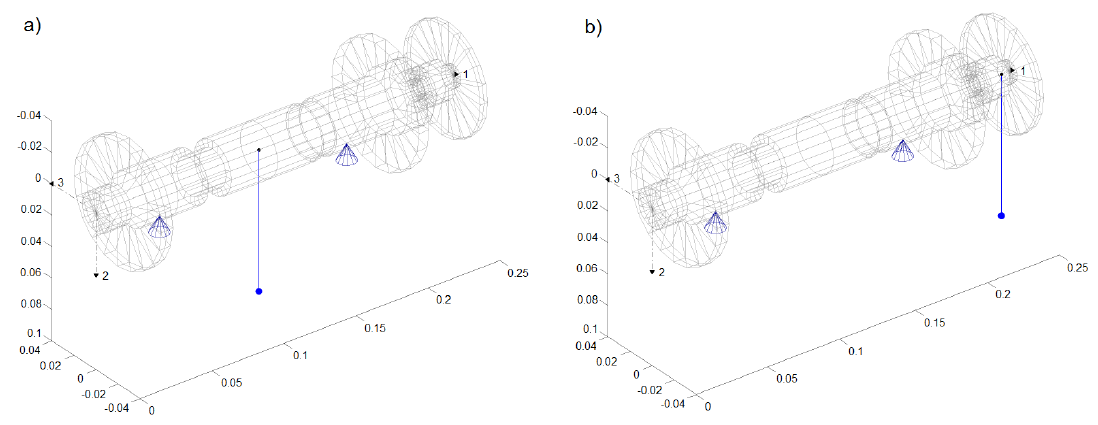
Figure 7: The model of micro-turbine rotor with unbalanced disc No. 2 (a) and disc No. 4 (b).